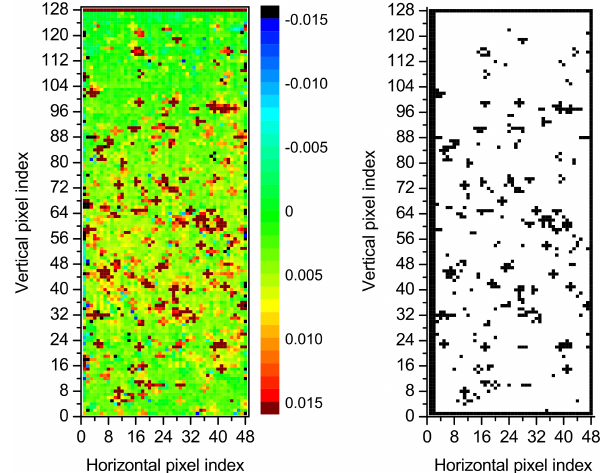
Figure 16. Left: relative deviation of calibrated measurements of the hot blackbody ( T = 256 . 6K) from the corresponding Planck function in the spectral range from 900 to 950cm − 1 . Right: bad pixel mask deduced from the radiometric error. Bad pixels are marked in